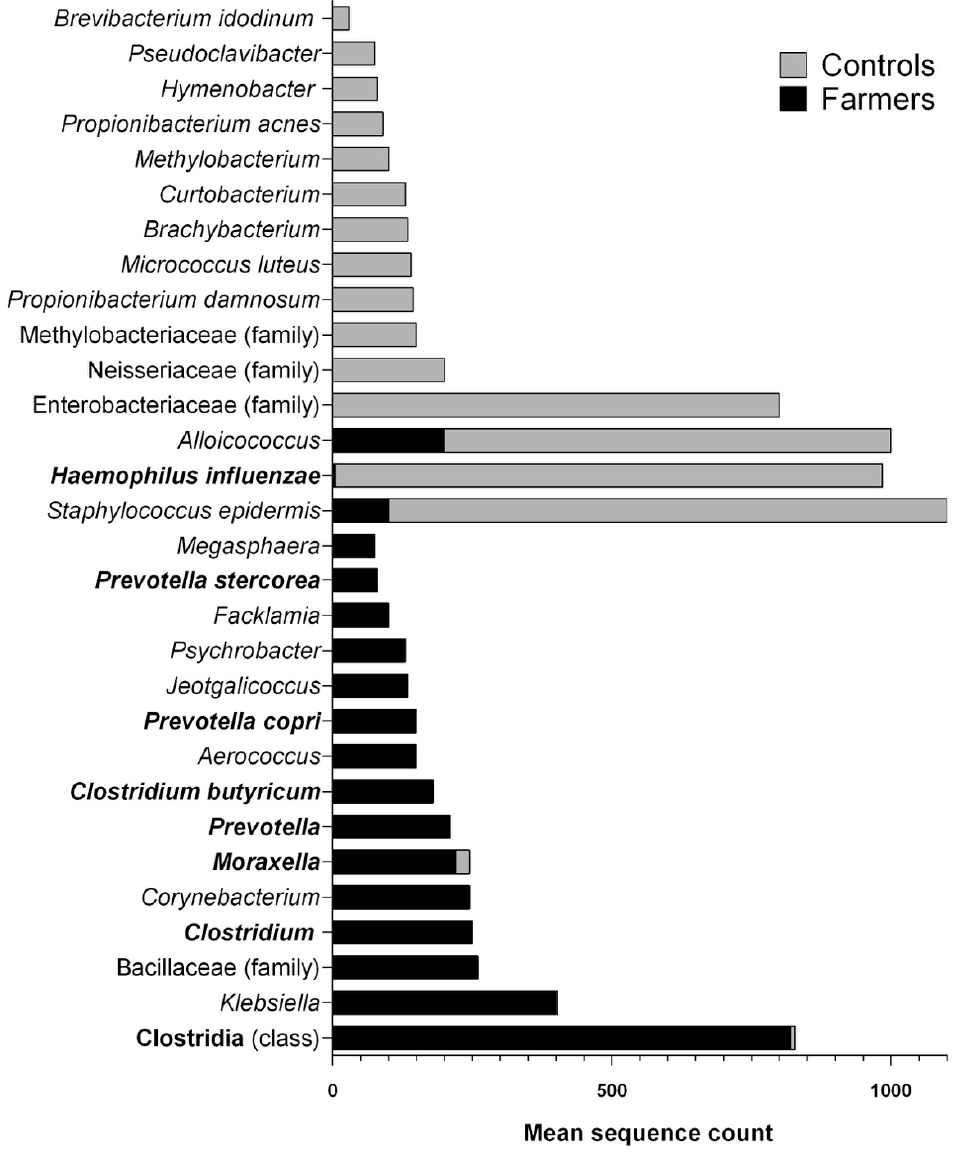
Figure 6. Taxa identified to highest possible taxonomic level with statistically significant differential abundances across pig farmers and non-exposed controls. From the bottom to the top: The first 15 taxa were the most abundant in samples from farmers and the last 15 were more abundant in non-exposed controls. The taxa written in bold type affect human health.